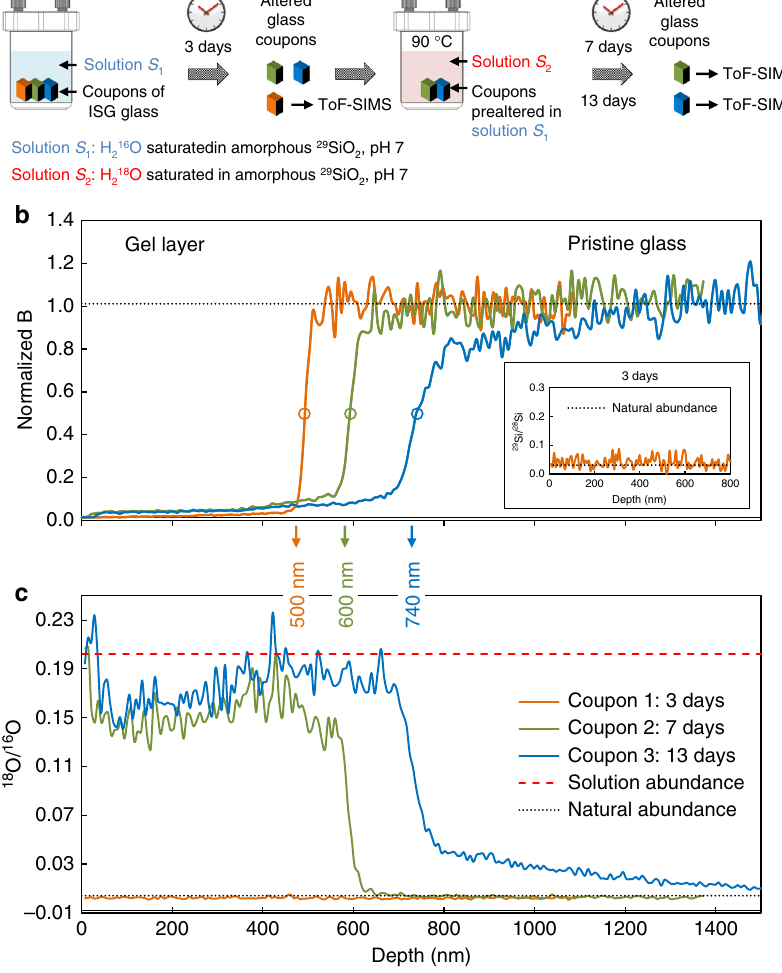
Fig. 6 Dynamics of self-reorganization of a young gel. Dynamics is monitored by ToF-SIMS depth pro fi ling (experiment 2). a Experimental protocol: piece 1 (orange) was altered for 3 days in solution S 1 only, piece 2 (green) was altered 3 days in solution S 1 followed by 4 days in solution S 2 , and piece 3 (blue) is similar to piece 2 but the alteration duration in solution S 2 was 10 days. b Normalized B pro fi les showing the position of the alteration front at the three considered durations. The inset displays the 29 Si/ 28 Si ratio in the gel of piece 1. Although the glass is altered in a solution highly enriched in 29 Si, the gel keeps the isotopic signature of the glass. c Oxygen isotopic pro fi les in the three gels. Contrary to Si, O in the gel displays an isotopic signature close to that of the solution. For ToF-SIMS pro fi les, only lines are displayed for a better readability, and the analytical step is 7 nm